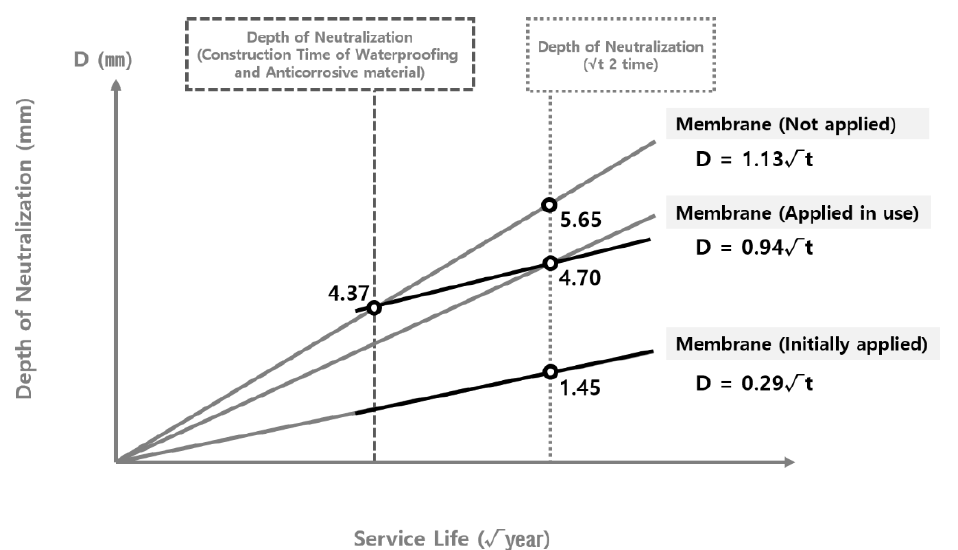
Figure 9. Derivation of carbonation rate coefficients of the water reservoirs with no waterproof- ing/anticorrosive method applied (upper limits).